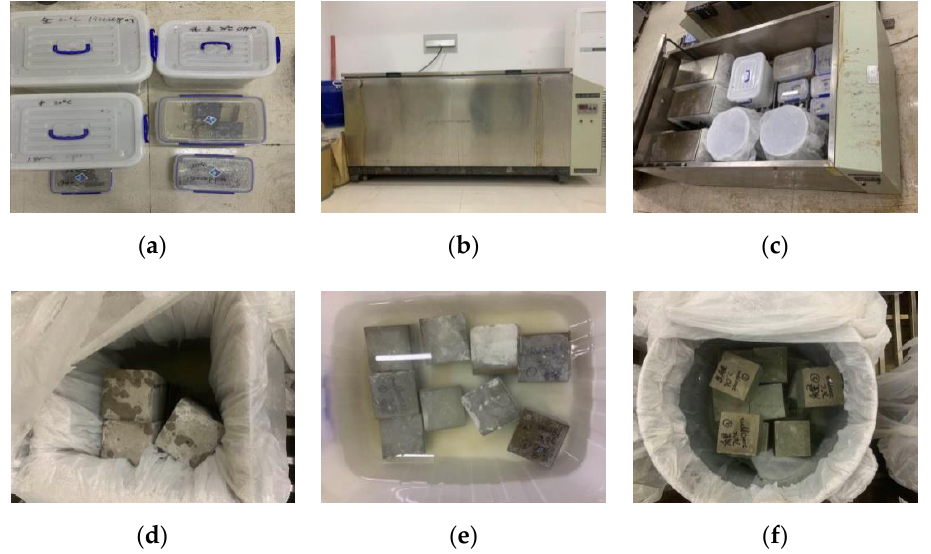
Figure 1. Process of boric acid curing. ( a ) Curing at 20 °C; ( b , c ) accelerated curing box; ( d ) curing at 40 °C; ( e , f ) curing at 70 °C.